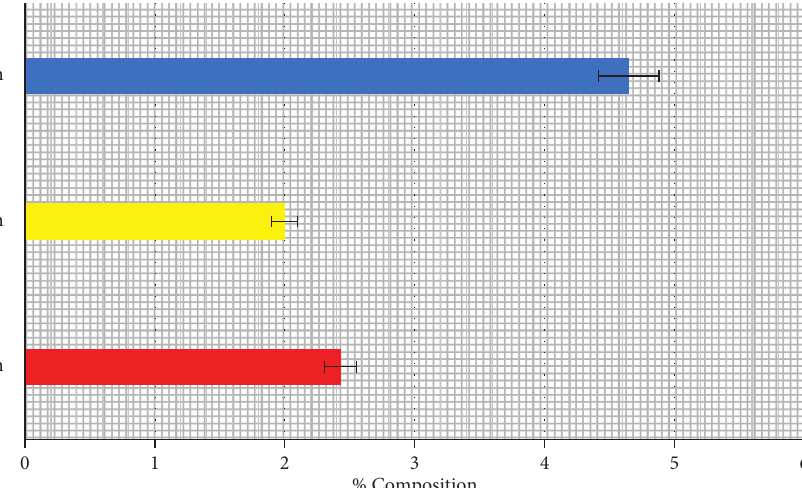
Figure 6: Percentage of unrefined fiber content of